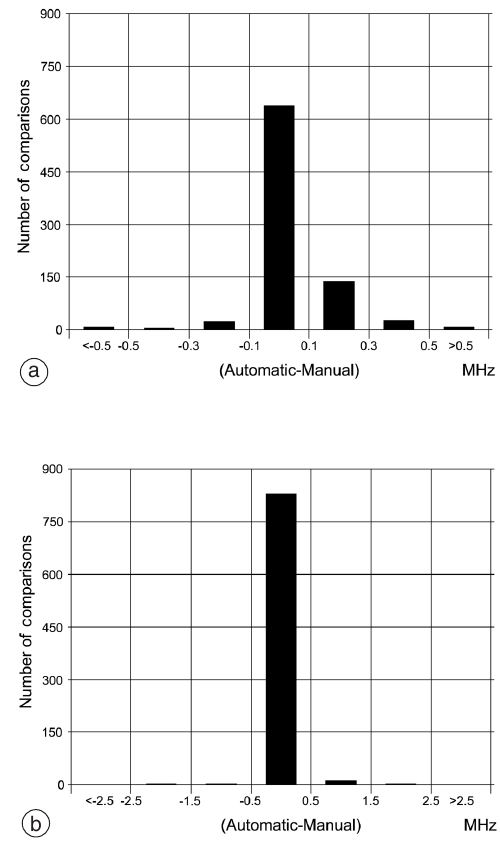
Fig. 1a,b. a) Differences ( δ ) between the values of f 0 F 2 scaled by Autoscala and by the standard manu- al method considering ionograms for which the op- erator was able to scale both f 0 F 2 and MUF(3000) F 2 (subset A). Out of 847 cases it results: for 638